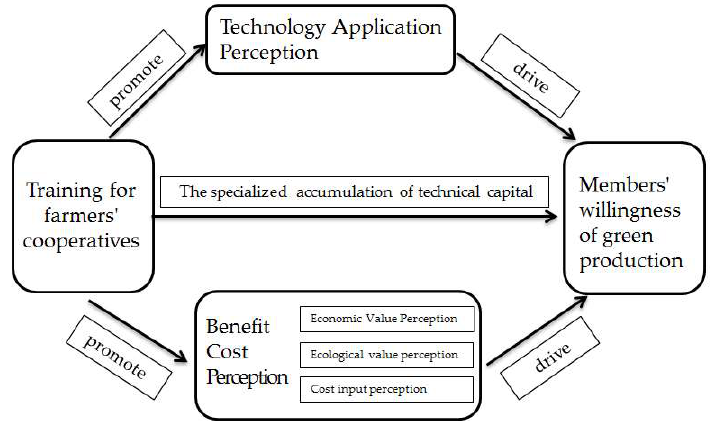
Figure 1. Theoretical model of members’ willingness to adopt green production